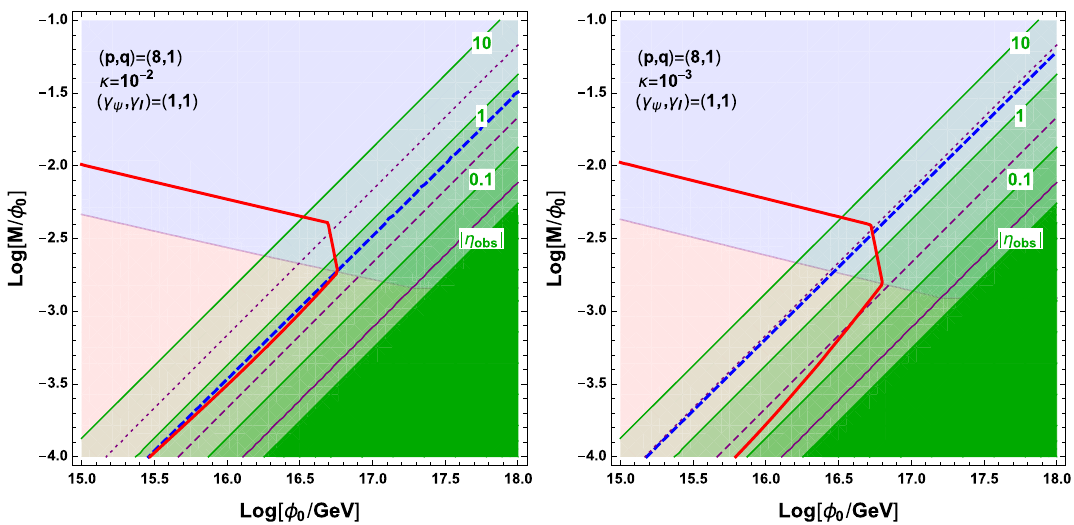
inflationaryobservables n s and P R foragiven κ whichsatisfiesEq.(44). The solid red line is for ( n B / s )/( Q α F ) = ( n B / s ) obs = 8 . 7 × 10 − 11 [1]. The line below the lower sharp breaking point is for H ψ > H osc . The line above the upper sharp breaking point is for H × < H I , d . Taking a smaller or larger γ I α shifts the red line left or right side for a given